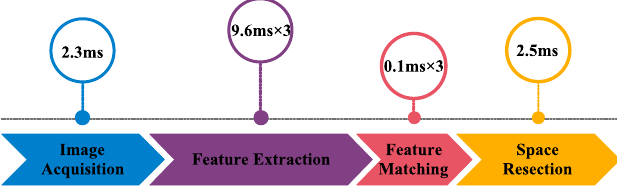
Figure 16. Consuming time of single